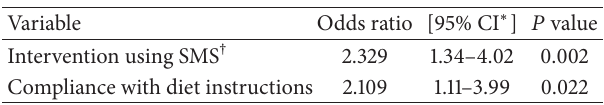
Table 5: Multivariate analysis of factors associated with satisfactory bowel preparation ( 𝑁 = 271